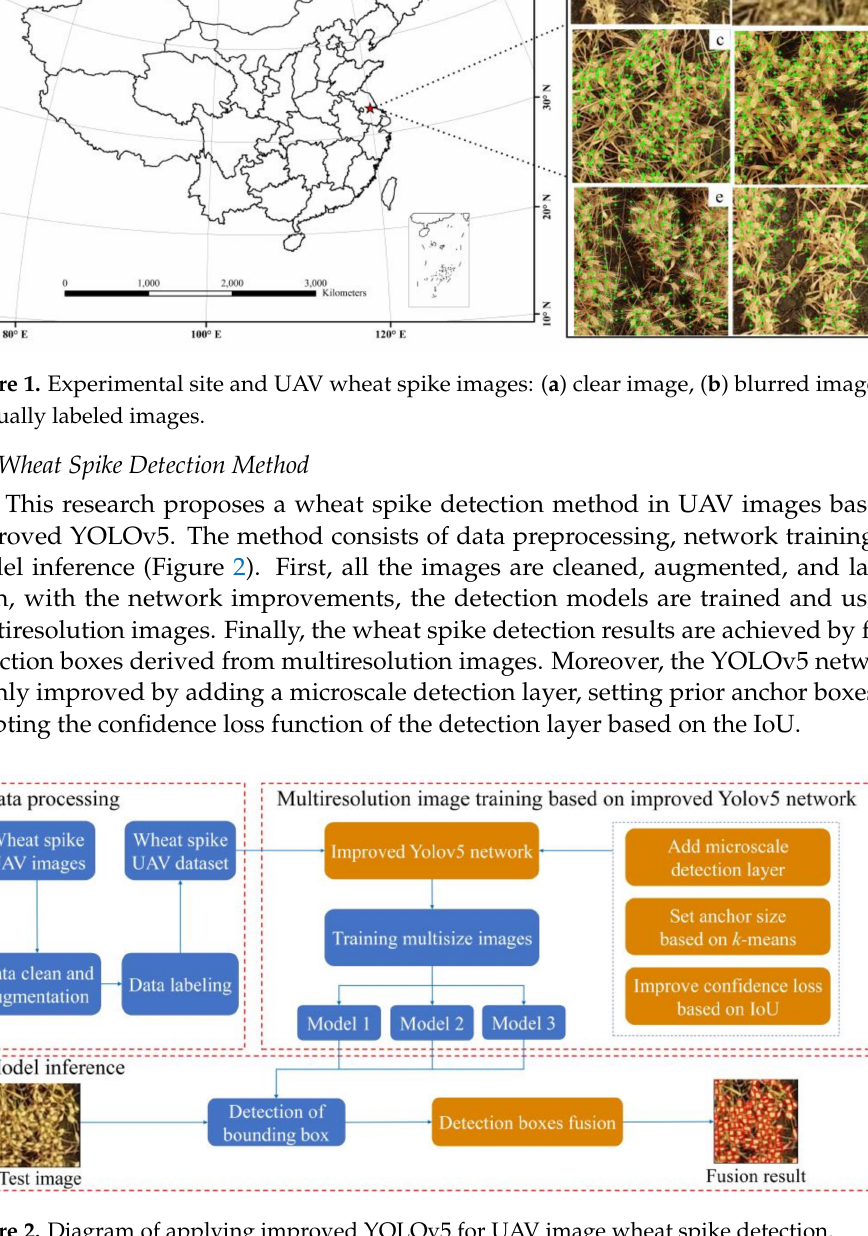
Figure 2. Diagram of applying improved YOLOv5 for UAV image wheat spike